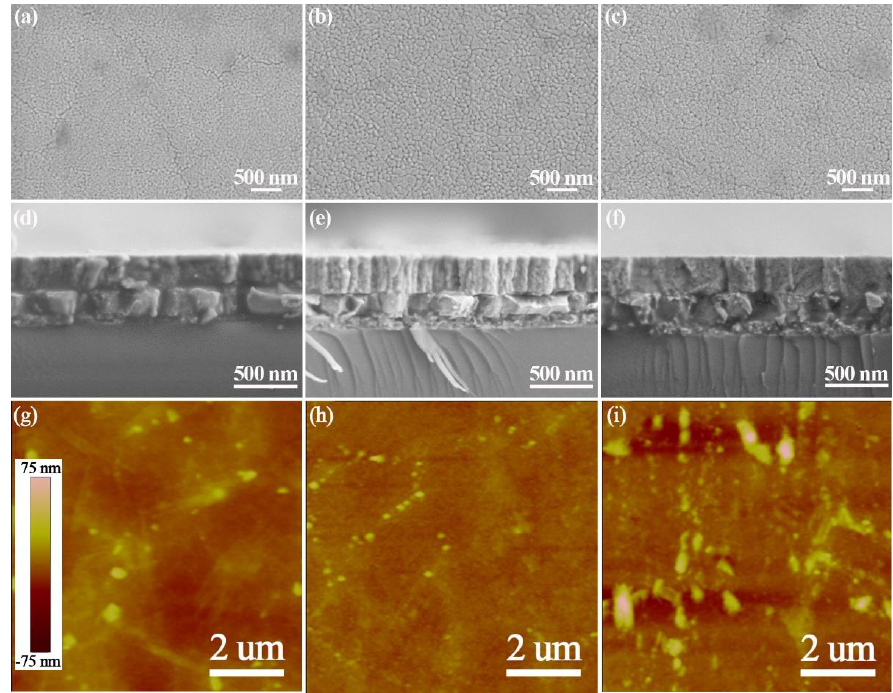
Figure 2. Microstructures of PMN-PT-2Fe thin films annealed at different temperatures. ( a , d , g ) 600 ◦ C; ( b , e , h ) 650 ◦ C; ( c , f , i ) 700 ◦ C. Note the cracks are observed in ( a , c ) and the uniform, dense and crack-free structure is obtained in ( b ), the typical columnar structure is shown in ( e ).